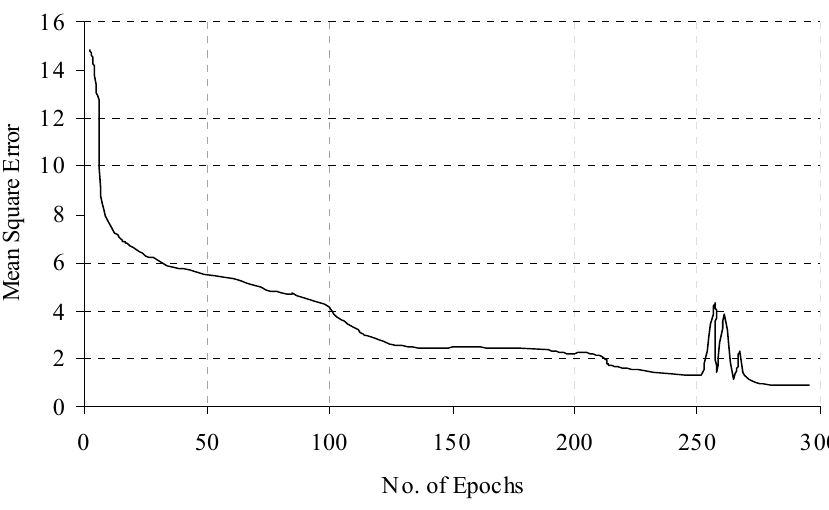
Figure 7. Training time error for the diabetes data.